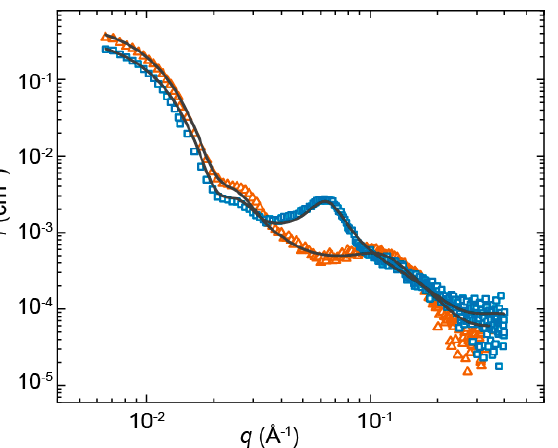
Figure 4. Measured small-angle X-ray scattering (SAXS) profiles of PUI-S2 :PMVP 29 - b -PEO 204 (open triangle, orange) and PUI-A2 :PMVP 29 - b -PEO 204 (solid square, blue), and computed models (solid line).